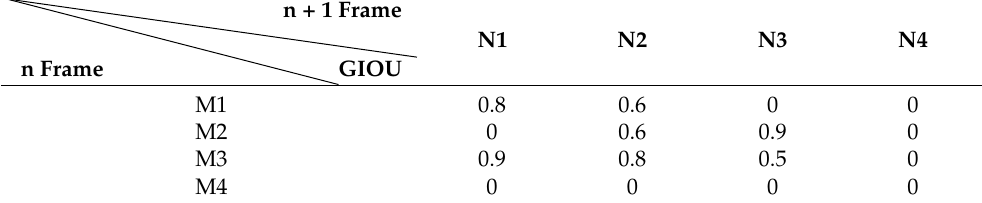
Table 1. Inter-frame target